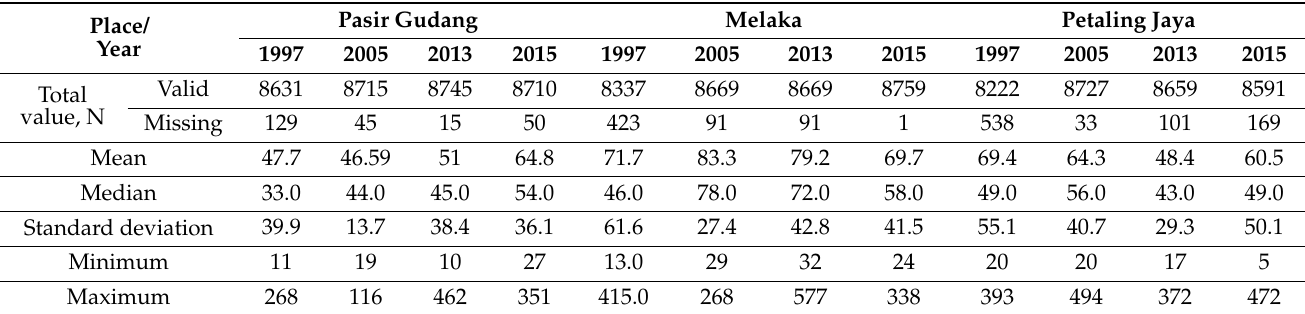
Table 5. Data summary for PM10 dataset in Pasir Gudang, Melaka, and Petaling Jaya in 1997, 2005, 2013, and